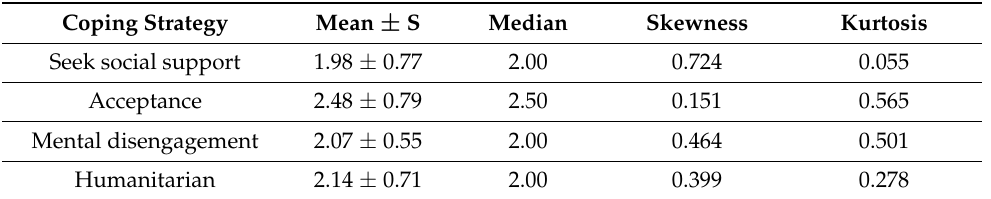
Table 2. Descriptive statistics for coping strategies.